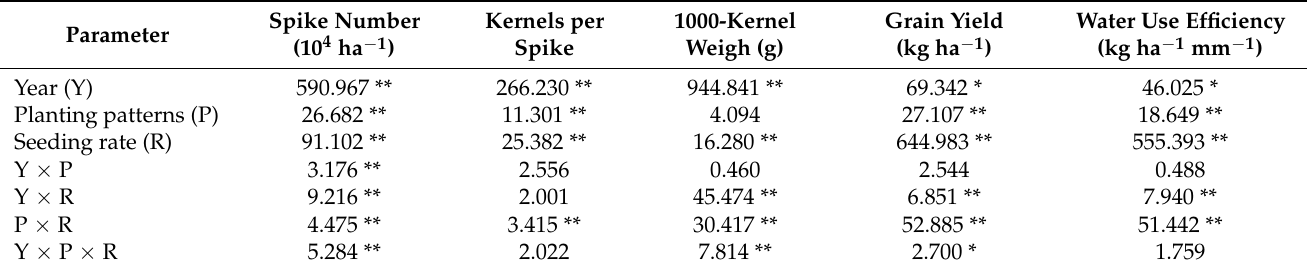
Table 5. Significance analysis (F value) of interactive effects of year, planting patterns, and seeing rate on the yield, its components, and water use efficiency in two years.